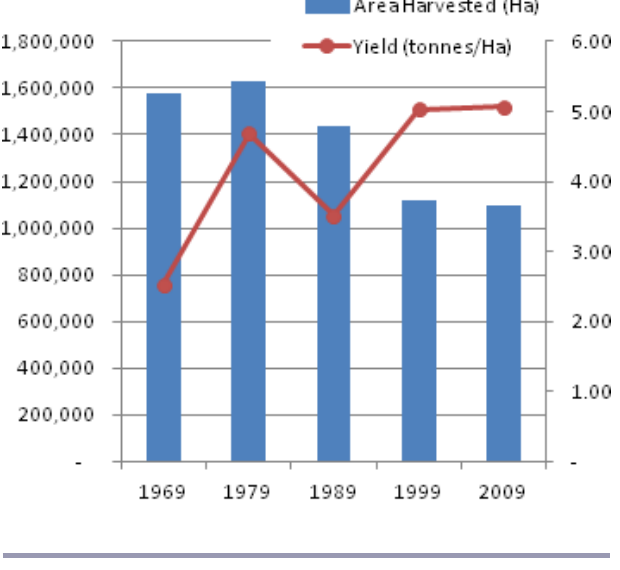
Fig. 5 . The change in grape production and harvest area in Spain. Data source: FAOSTAT